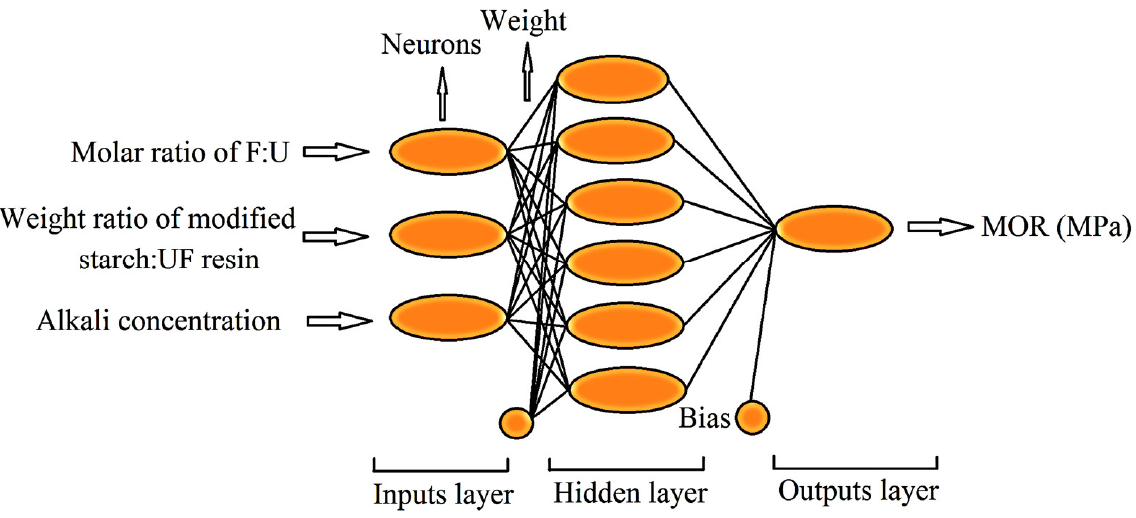
Figure 1. The ANN architecture used as the prediction model of MOR.